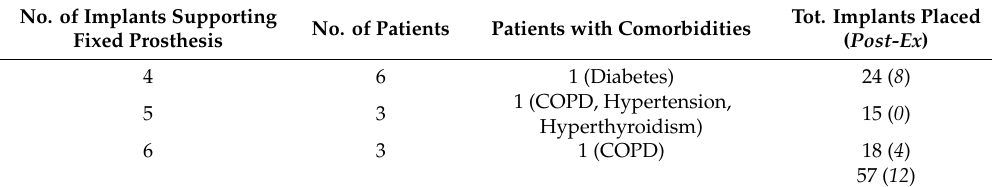
Table 2. Implant distribution.